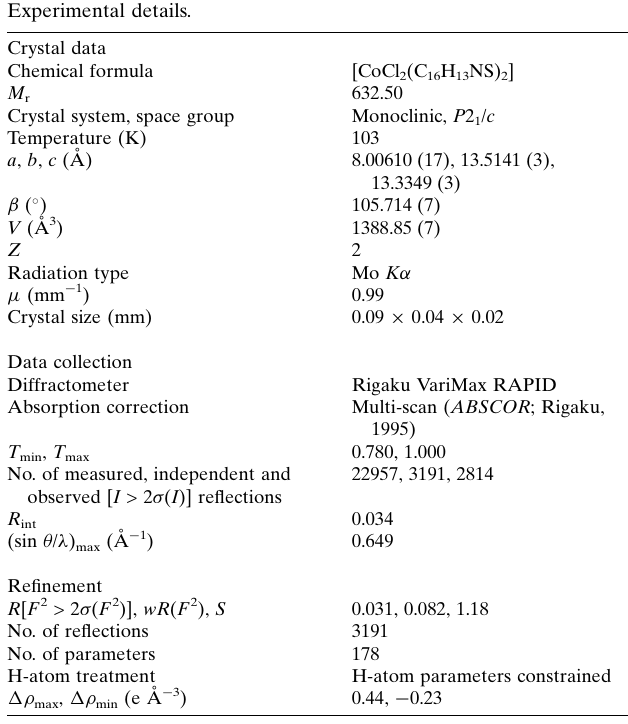
Table 2 Experimental details.